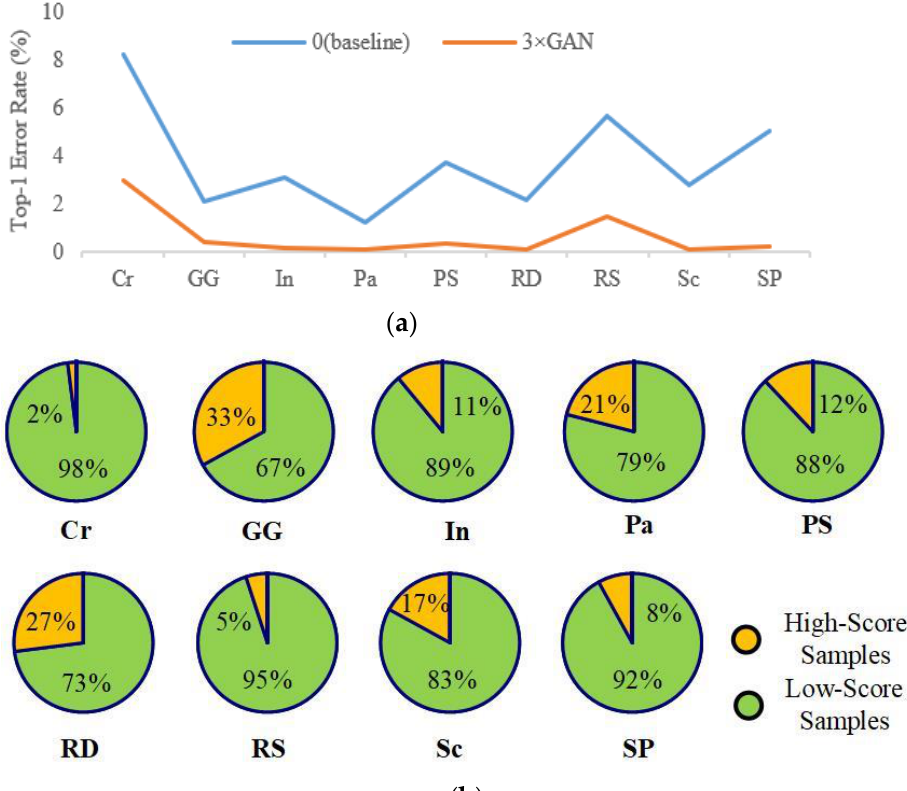
Figure 5. The effects of adding GAN samples on each defect class of NEU-CLS-64. ( a ) The Top-1 error rate comparison between no GAN samples added (baseline) and adding 3 × GAN samples. ( b ) The percentage of high-score samples and low-score samples of each defect class in the 3 × GAN samples.